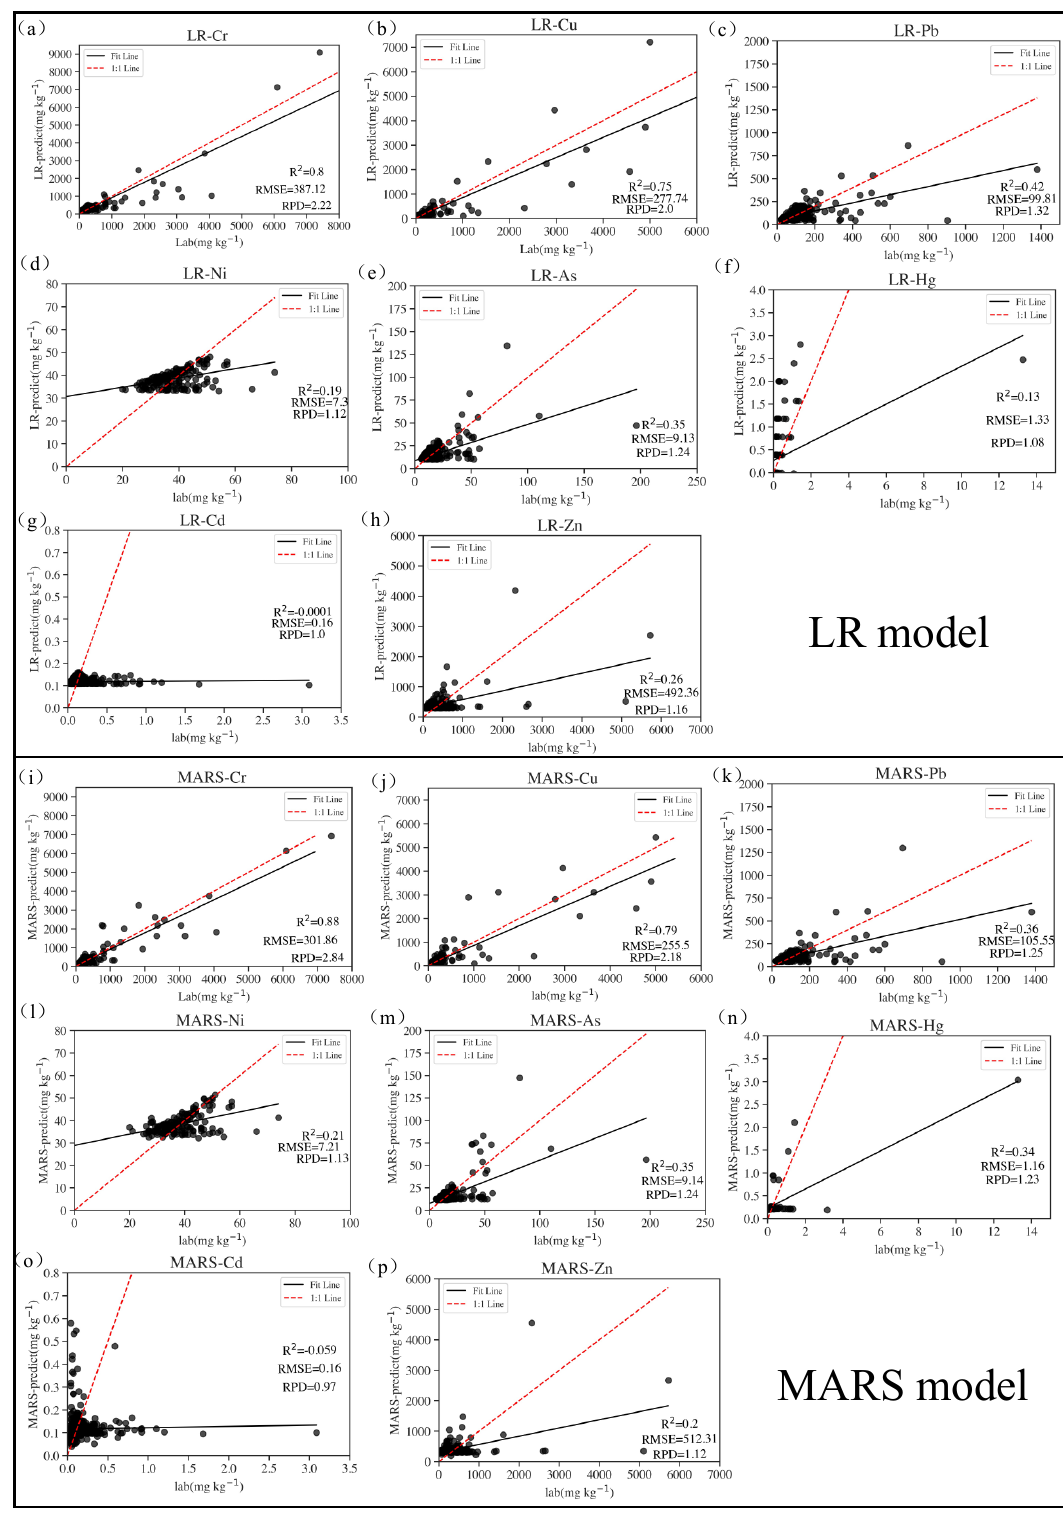
Figure 4. Concentrations of heavy metals predicted from each pXRF measurement using LR and MARS models against laboratory values of samples in the pXRF high-value dataset. The red dashed line is the 1:1 line, the black line is the regression line, and the points are semi-transparent to show point density. ( a – h ) Prediction results of LR models. ( i – p ) Prediction results of MARS model.